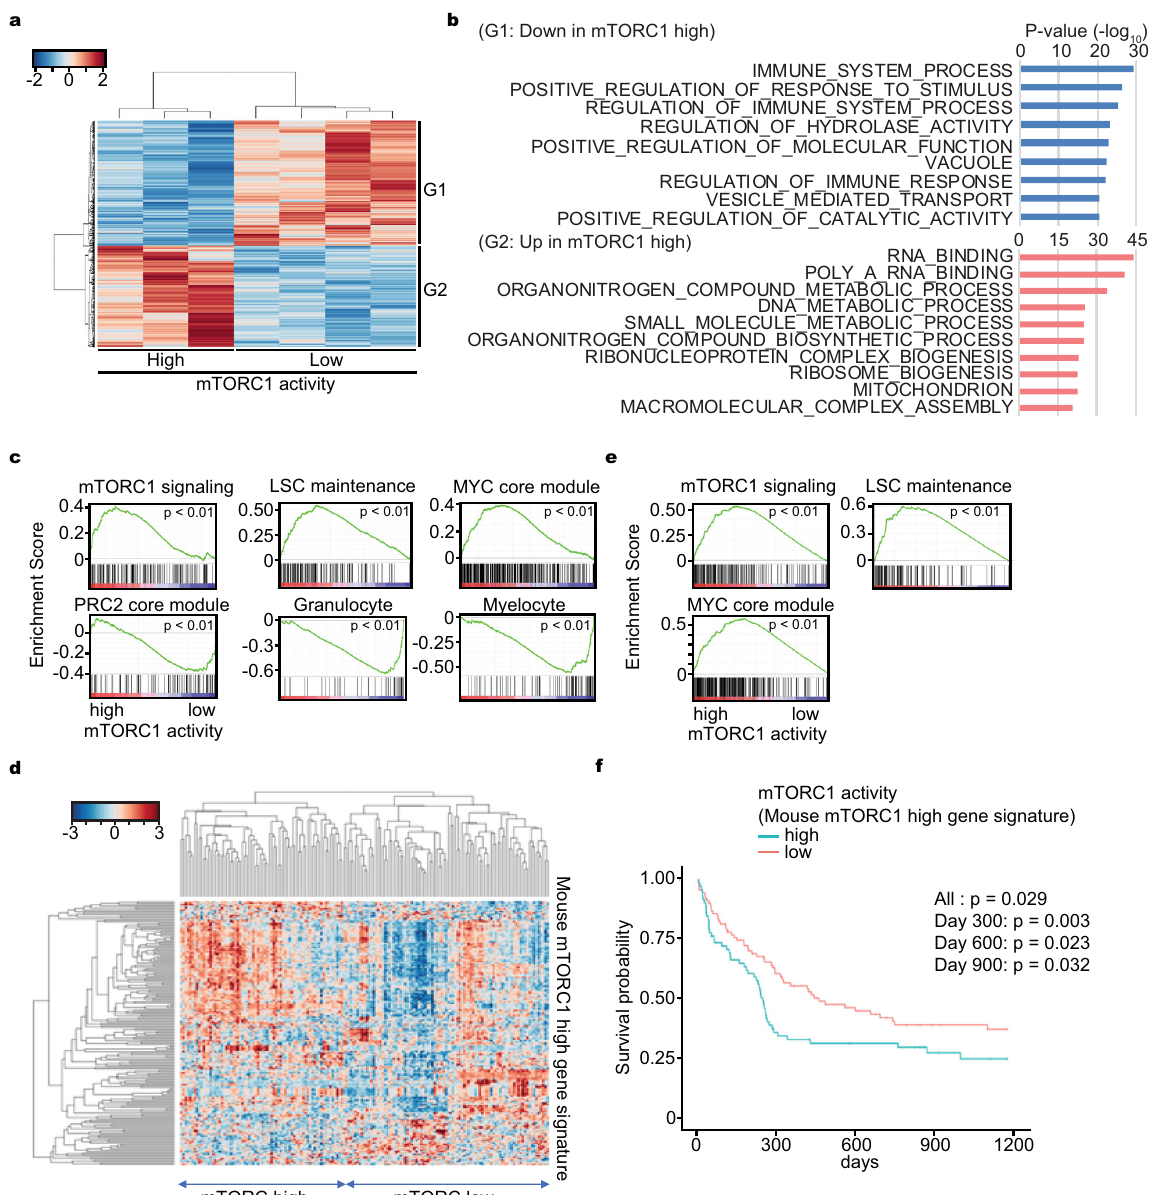
Fig. 3 Expression pro fi ling between mTORC1 high and low AML cells. a Clustering analysis of transcriptomic data obtained from mTORC1 high or low AML cells harvested from mouse bone marrow. b Gene ontology analysis of differentially expressed genes obtained from mTORC1 high or low AML cells harvested from mouse bone marrow. c Gene set enrichment analysis (GSEA) of differentially expressed genes obtained from mTORC1 high or low AML cells harvested from mouse bone marrow. d Classi fi cation of human AML samples (GSE12417) with the mouse mTORC1 high AML cell gene signature (mouse mTORC1 high gene signature). e GSEA of transcriptomic data (GSE12417) obtained from human AML samples classi fi ed according to their expression of the mouse mTORC1 high gene signature. f Overall survival probability of AML patients classi fi ed according to their expression of the mouse mTORC1 high gene signature. Overall log-rank test p -value (All) and the p -value at different time points (day 300, 600, and 900) were